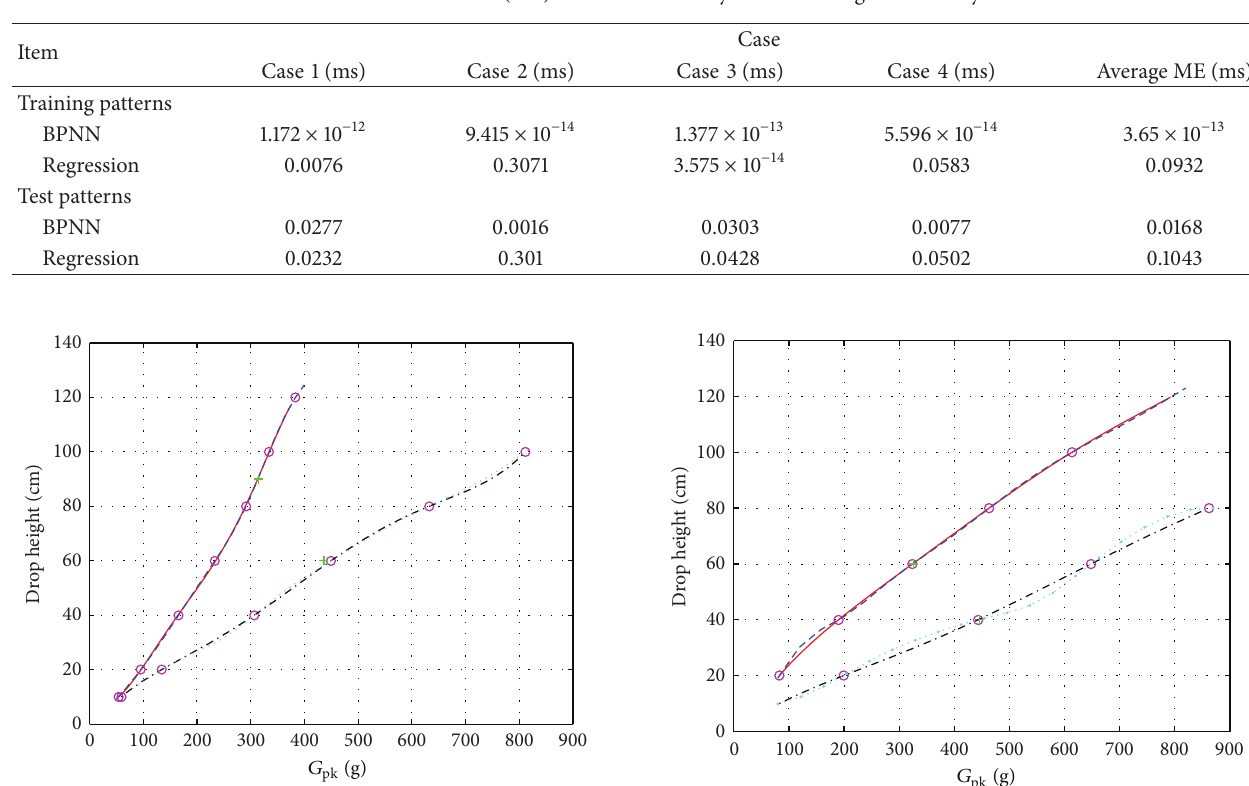
Table 6: Maximum errors (ME) of time duration by BPNN and regression analysis.